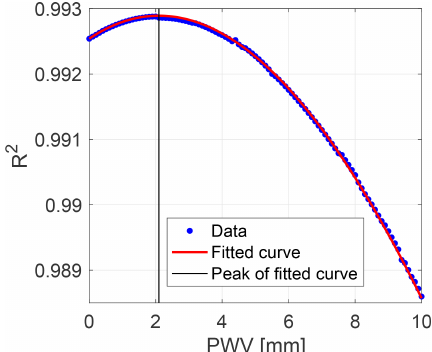
Figure 5. Correlation coefficient R 2 to a straight line in the Boltz- mann plot as a function of PWV used to correct the OH line inten- sities from the HiTIES spectrum recorded on 15 December 2015 at 01:40UT (from Fig. 2). The blue points are values of R 2 produced by the fitting process for each assumed value of PWV. The red curve is a fit to these points and is used to determine the PWV at which R 2